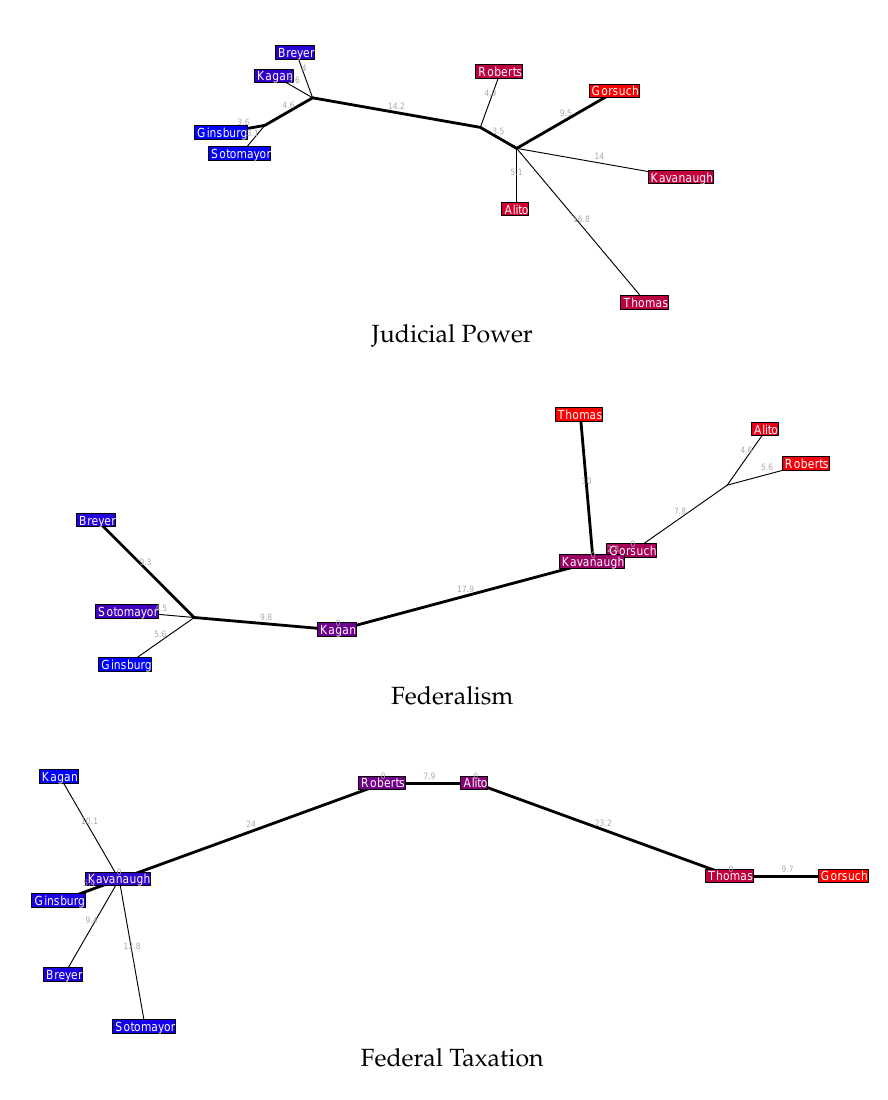
Figure 13. More judicial trees for the 2018–2020 Roberts 7 Court, separated by issue area. The tree for Economic Activity cases is very similar to the overall tree for this natural court, though curiously MDS seems to consider Alito and Thomas closer to the center of the Court here than the tree does (and also closer to the center than MDS does when combining all case issue areas). The tree for Judicial Power cases shows a fairly tight cohesion and little branching from the major axis among the liberal justices—but the conservative justices are fairly spread out, and mostly in non-political dimensions (by which, as usual, I mean dimensions beyond the primary liberal-conservative spectrum measured by the major axis). Alito, and Roberts are all colored staunchly conservative by the MDS estimate, but